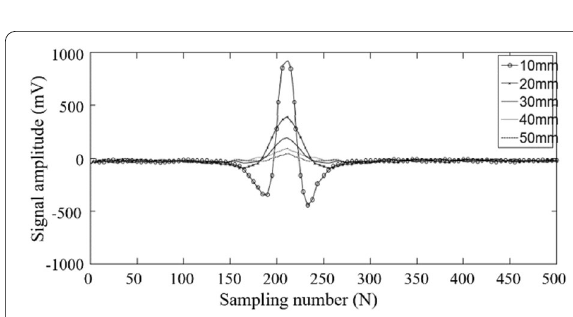
Figure 18 Schematic diagram of MFL testing for deep-buried inner defects